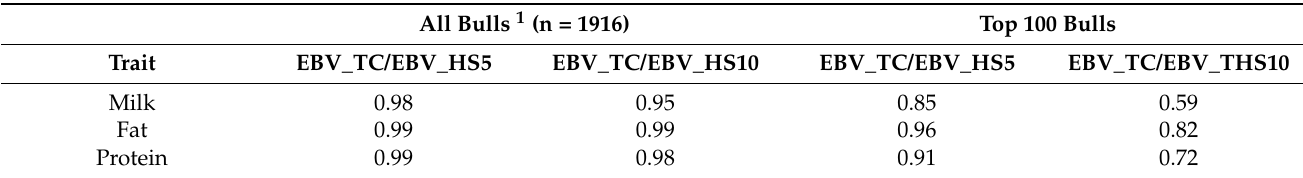
Table 4. Spearman rank correlation between estimated breeding value under thermal comfort (EBV_TC) and breeding values estimated on five units (EBV_HS5 = EBV_TC + 5 × EBV_HT) and ten